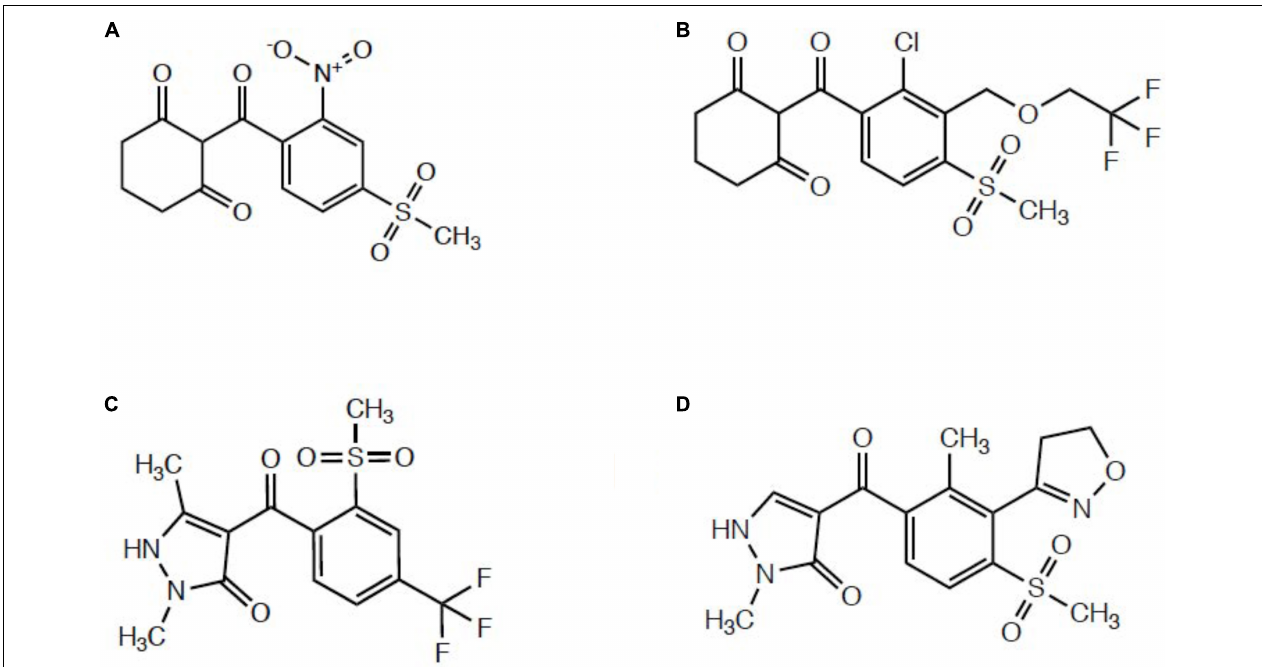
FIGURE 1 | Representative structures from different subclasses of commercial HPPD-inhibiting herbicides. (A) Mesotrione, a triketone. (B) Tembotrione, a triketone. (C) Pyrasulfotole, a pyrazolone. (D) Topramezone, a pyrazolone.